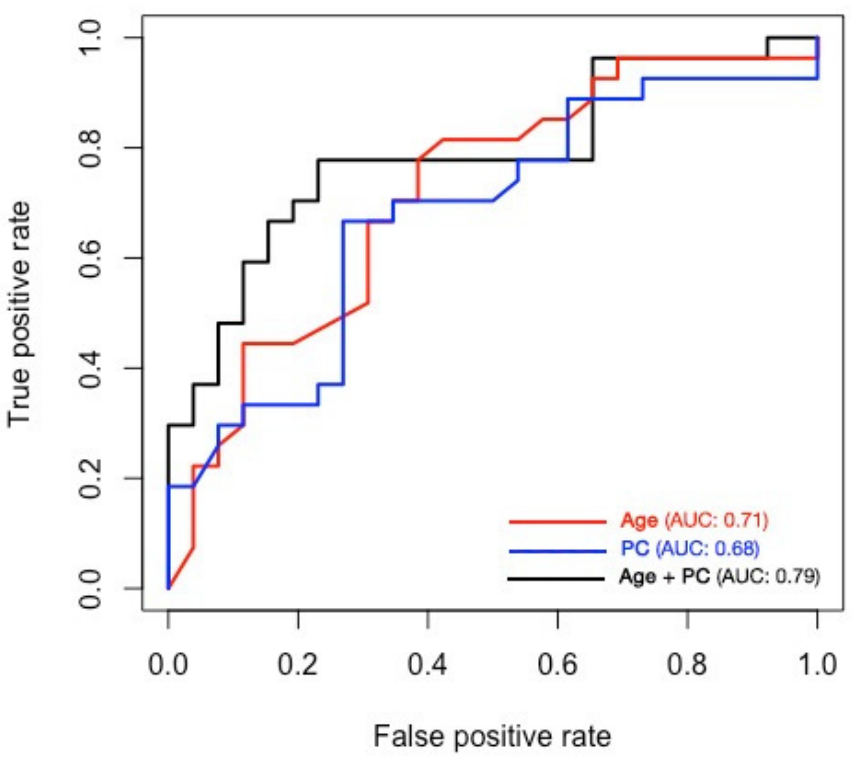
Figure 2. The areas under the ROC curve of models 1, 2, and 3. Abbreviations: area under the curve (AUC), platelet count (PC), receiver operating characteristic (ROC).